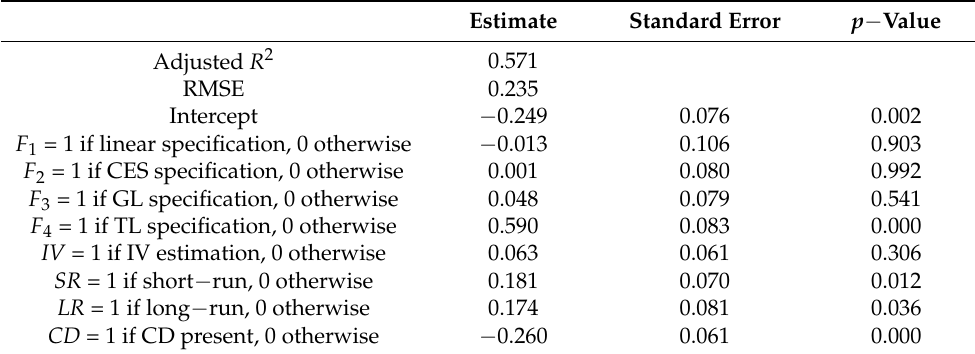
Table 5. OLS dummy variable regression; the regressand is the own-price elasticity estimate for US residential natural gas demand; sample size = 60 observations = 5 specifications × 2 estimation methods × 3 elasticity types × 2 CD